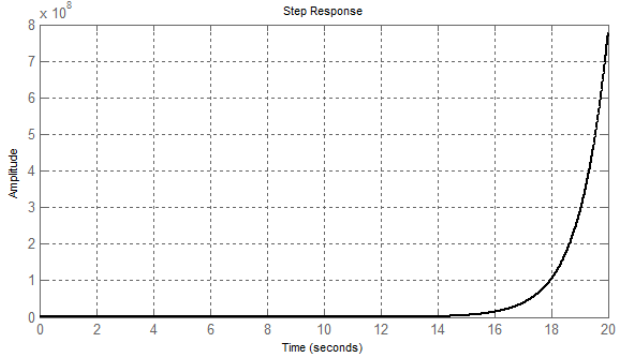
Figure 12. The transition function in this case.